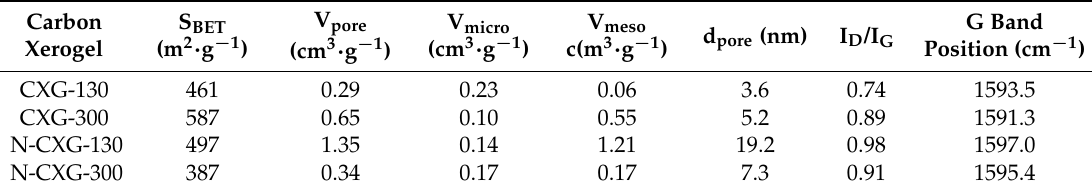
Table 1. Textural properties (determined from N 2 adsorption isotherms) and structural parameters (as determined from Raman